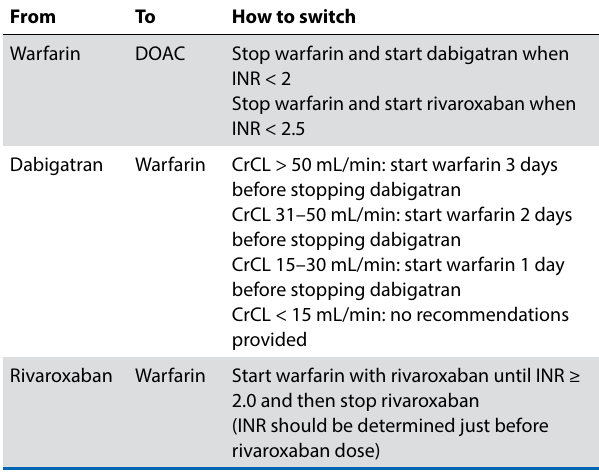
Table II. Switching between DOACs and warfarin From To How to switch Warfarin DOAC Stop warfarin and start dabigatran when INR <